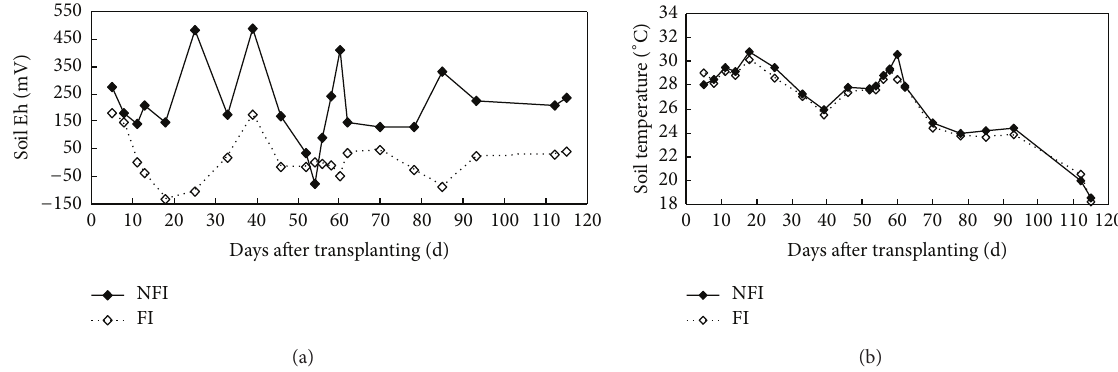
Figure 2: Seasonal variation of soil Eh and soil temperature at 5cm depth in rice fields under different water managements.